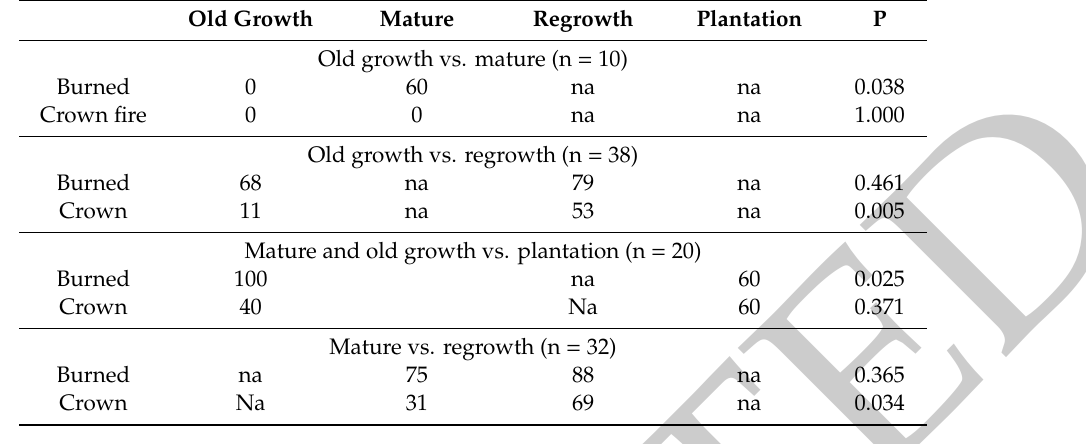
Table 2. Percentage of stands that were burned and percentage that had crown fires by forest type, showing significance of di ff erences between forest types (Chi 2 ). Old Growth Mature Regrowth Plantation P Old growth vs. mature (n =